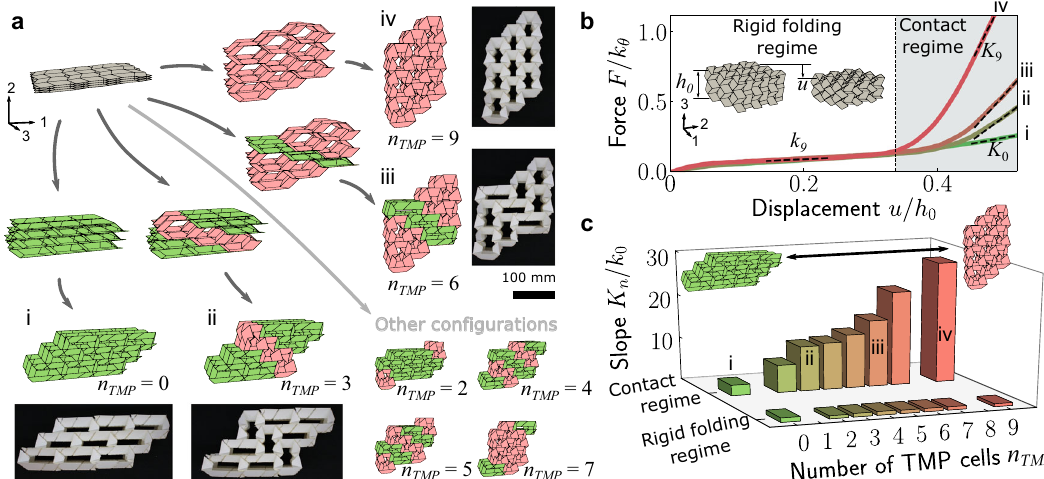
Fig. 3 Origami tessellation with in situ tunable self-contacting vertices. a 3 × 3 close-packed assembly can transform from its fl at state into multiple con fi gurations containing different numbers of TMP cells n TMP (red-colored cells): (i) n TMP = 0, (ii) n TMP = 3, (iii) n TMP = 6, and (iv) n TMP = 9 (all TMP con fi guration). In addition to these four con fi gurations, the lower right inset illustrations show other possible transformed shapes. The inset photographs with scale bar of 100 mm show our paper prototypes of their corresponding con fi guration. b Experimentally measured force-displacement relationships for the above four con fi gurations. The force is normalized by the torsion spring constant obtained from the unit cell compression test (Fig. 2b), and the displacement is normalized by the initial height of the prototype before compression is applied. We extract the slope of each force curve in the rigid folding and contact regimes (see the dashed lines). c The values of slope in the rigid folding regime ( k n ) and contact regime ( K n ) are plotted as a function of the number of TMP cells ( n TMP ) contained in the tessellation. The slope is normalized by k 0 , i.e., no TMP